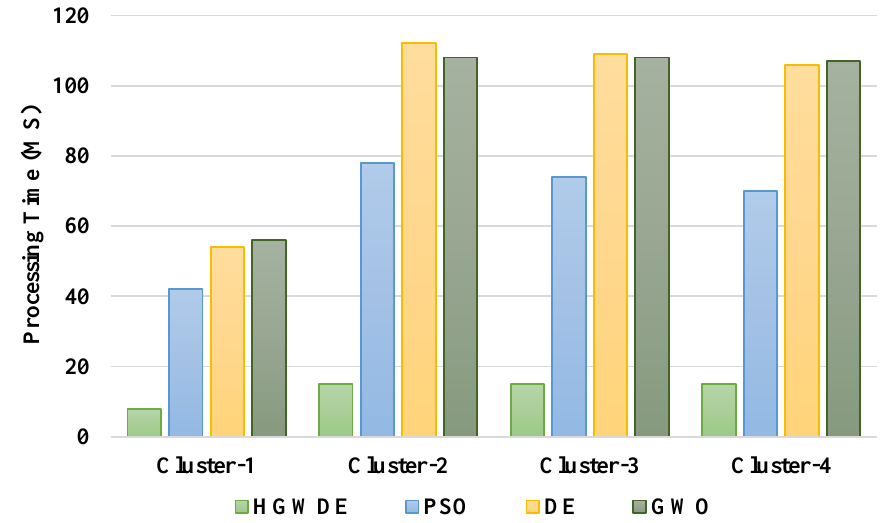
Figure 4. Comparing processing time of various algorithms.